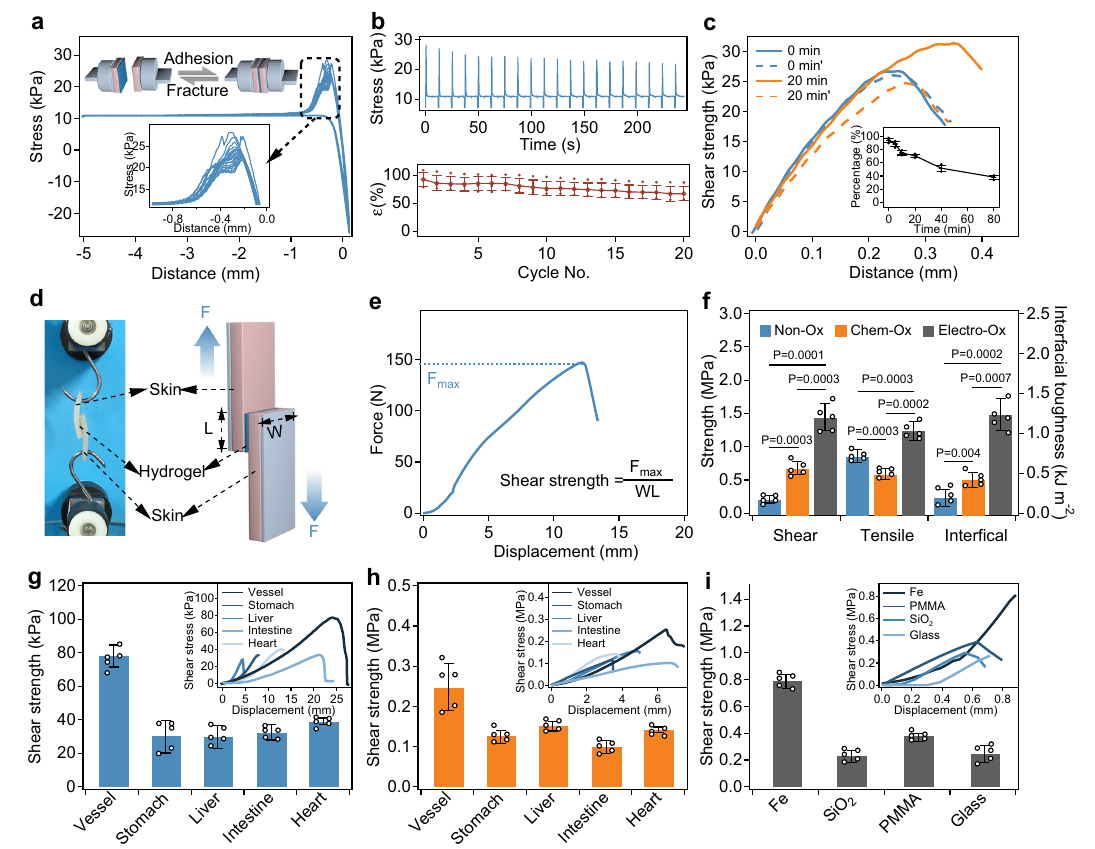
Fig. 3 Adhesion performance of the Electro-Ox hydrogel tape. a Cyclic compression and fracture curves versus displacement of instant adhesion for porcine skin using Electro-Ox hydrogel tape in 20 cycles. The top inset corresponds to a schematic of the compression and fracture cycles. The bottom inset corresponds to the magni fi ed fracture curves. b Cyclic compression and fracture curves versus time (top) and normalized tensile strength ( ε , bottom) of instant adhesion for porcine skin using Electro-Ox hydrogel tape in 20 cycles. Values represent the mean and standard deviation ( n = 3 independent samples). c Typical lap shear curves of instant adhesion (0 min), adhesion after the fracture of initial adhesion (0 min ’ ), adhesion after curing for 20 min (20 min), and instant adhesion after the fracture of 20 min adhesion (20 min ’ ). The inset corresponds to the normalized tensile strength of a second instant adhesion event after different times (normalized 0 min ’ , 5 min ’ , 10 min ’ , 20 min ’ , 40 min ’ , and 80 min ’ ). Values represent the mean and standard deviation ( n = 3 independent samples). d Image and schematic for the measurement of shear strength based on the standard lap shear test. F force, W width, L length. e Typical force – displacement curve recorded in the lap shear test and the determination of shear strength. f Shear strength, tensile strength, and interfacial toughness of long-term adhesion for different hydrogels. P values, two-tailed Student ’ s t test. No adjustments were made for multiple comparisons. g , h Shear strength of short-term ( g ) and long-term ( h ) adhesion for different porcine organs using Electro-Ox hydrogel tape. i Shear strength of long-term adhesion for different substrates (Fe, SiO 2 , PMMA, and glass) using Electro-Ox hydrogel tape. Insets of g – i correspond to the typical force – displacement curves recorded in the lap shear tests. Values in f – i represent the mean and standard deviation ( n = 5